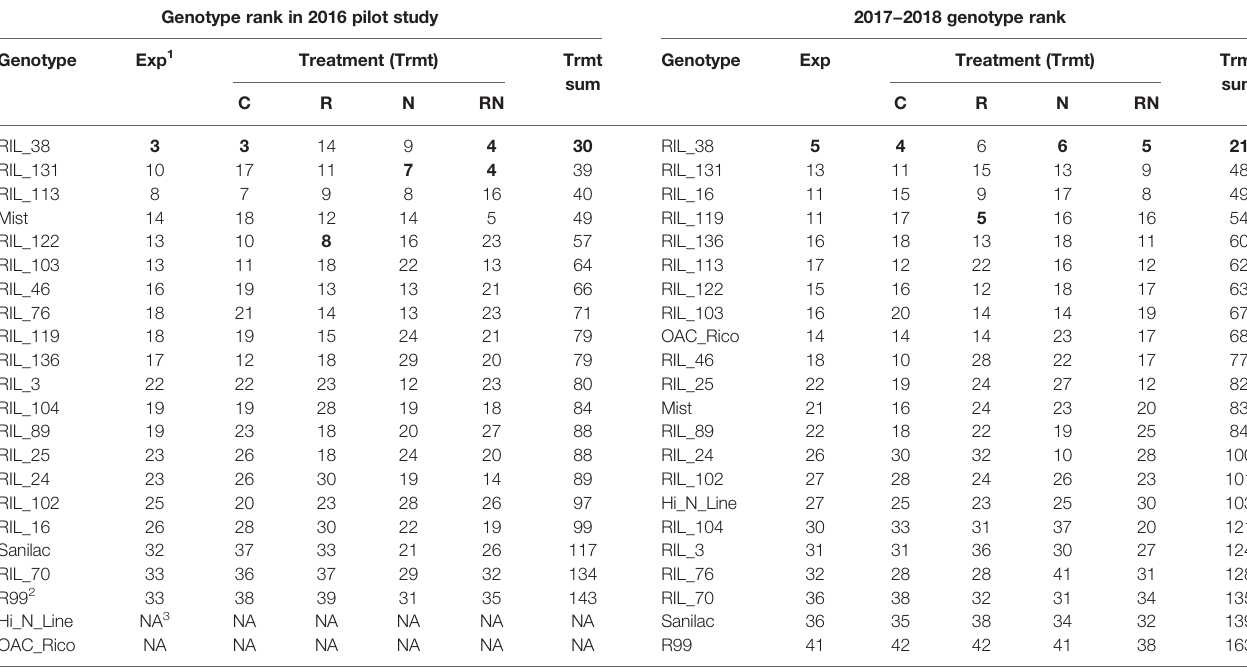
TABLE 10 | Ranking of the common bean genotypes based on the yield and %Ndfa values (genotype rank = %Ndfa rank + YD rank). Genotype rank in 2016 pilot